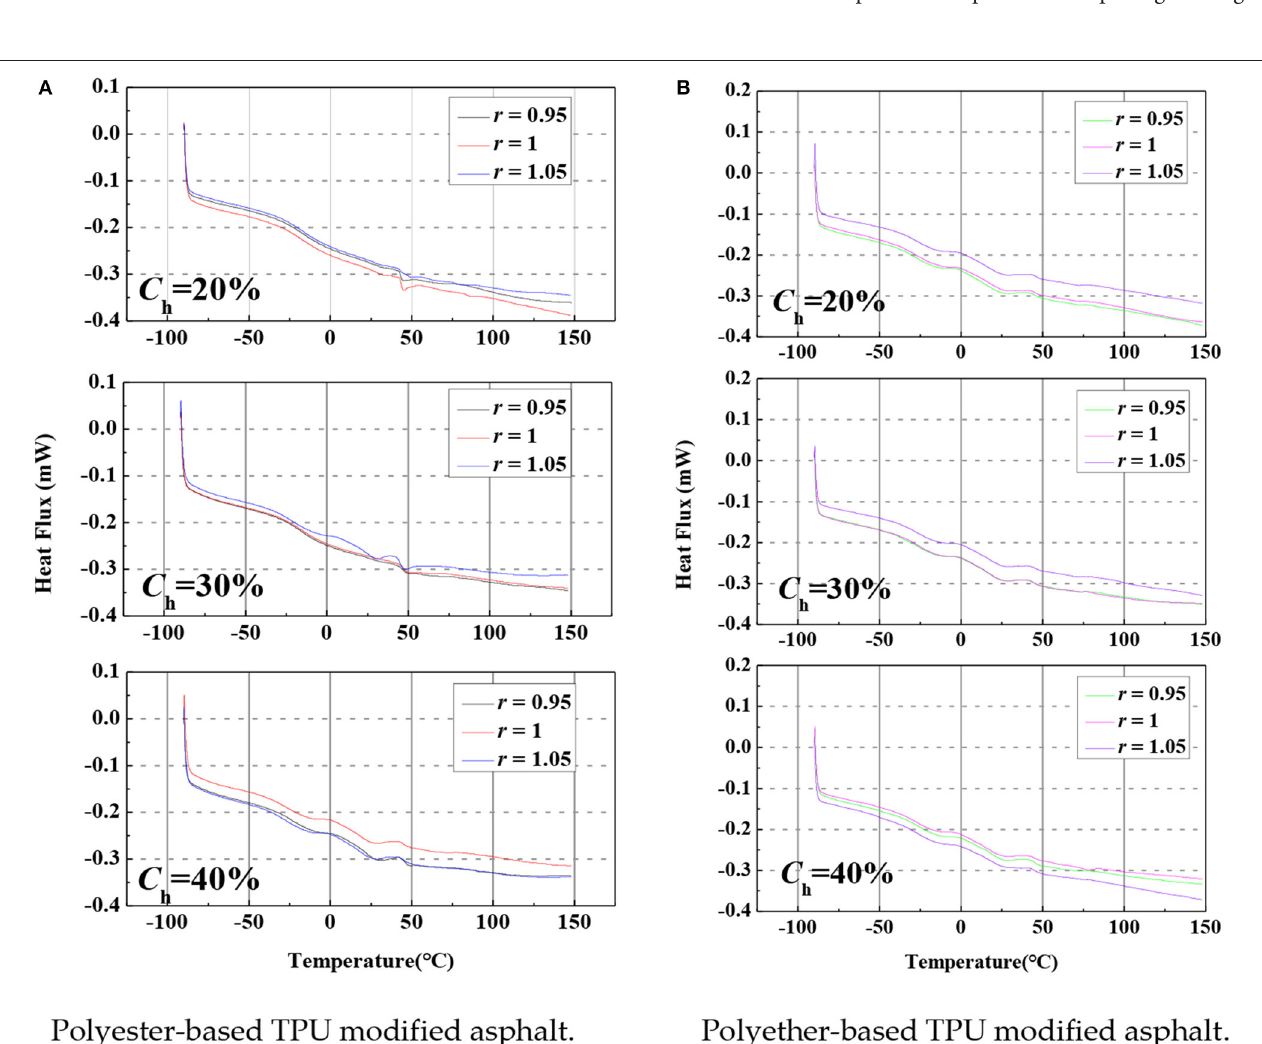
FIGURE 26 | DSC curves of TPU-modified asphalt. (A) Polyester-based TPU-modified asphalt. (B) Polyether-based TPU-modified asphalt.